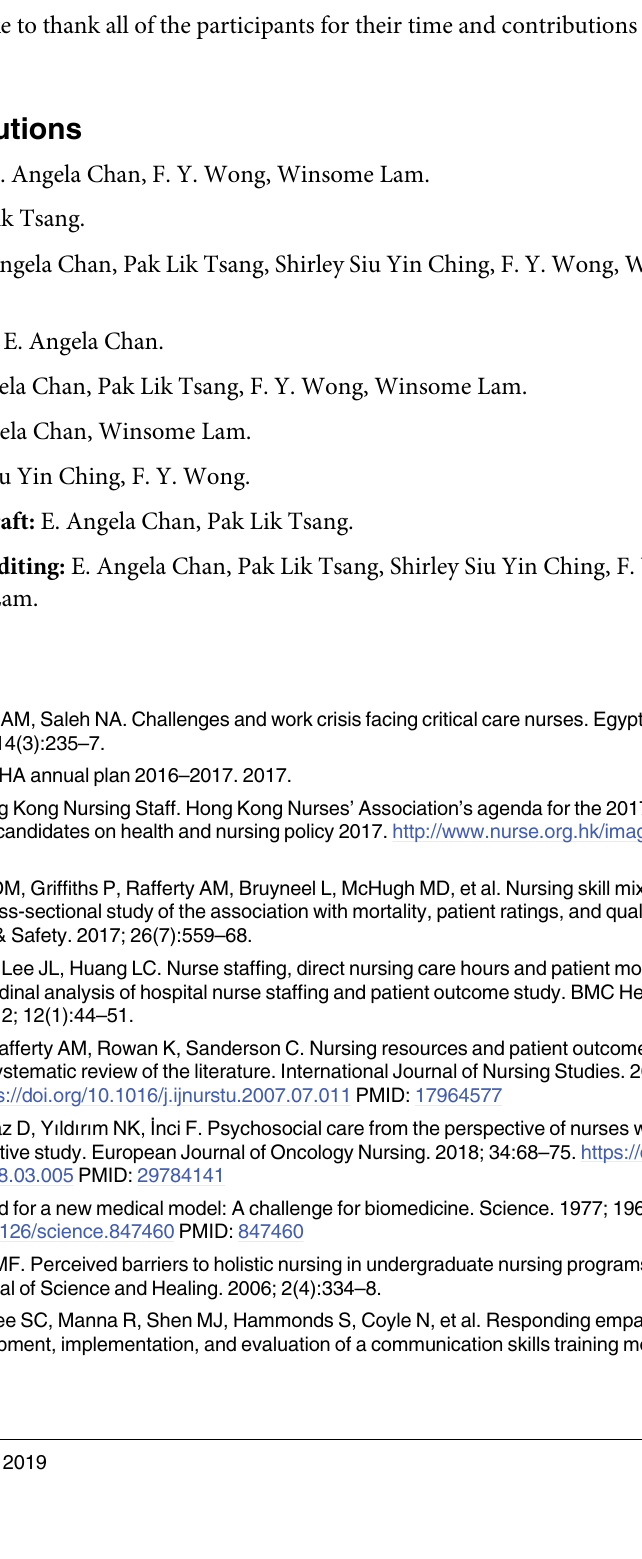
S2 Fig. Developed thematic map of the qualitative findings. (DOCX) S3 Fig. Final thematic map of the qualitative